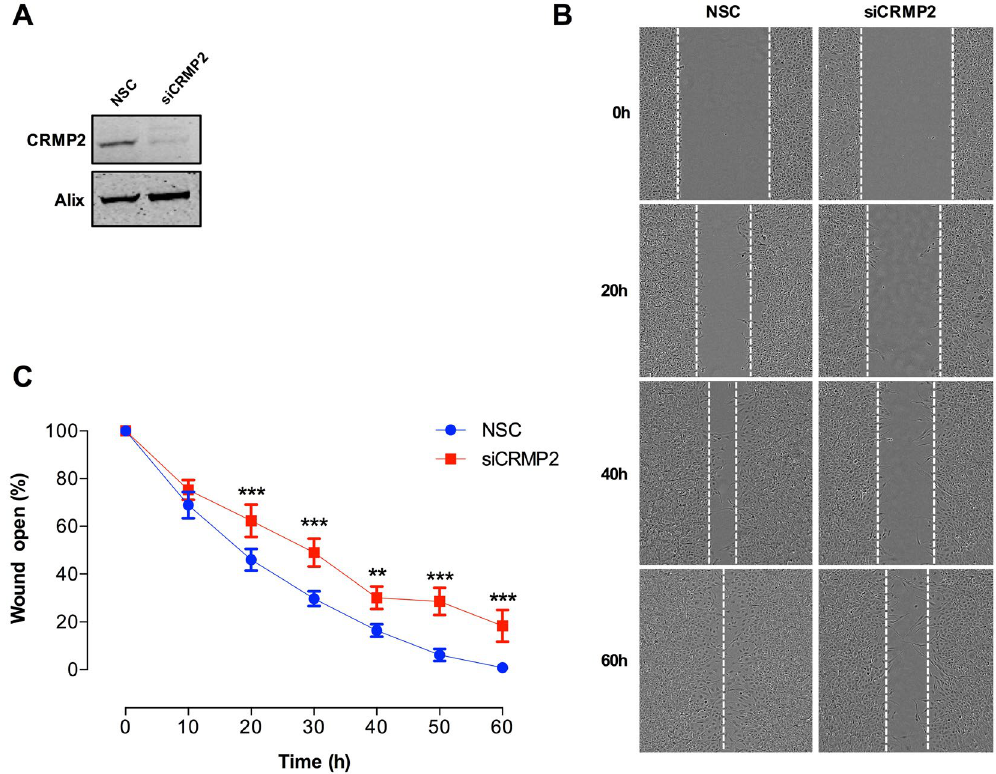
Figure 7. CRMP2 plays a role in PDGF-induced cell migration. ( A ) Representative western blot showing levels of CRMP2 in MEFs following transient transfection with non-silencing control siRNA (NSC), or with CRMP2 siRNA (siCRMP2). Alix was used as a loading control. For uncropped images of blots see Supplementary Fig. S4. ( B ) Transfected MEFs were wounded using an automated scratch maker and stimulated with 20 ng/ ml PDGF. Images of five separate wounds were taken at 0, 10, 20, 30, 40, 50, and 60 h post wounding using the IncuCyte ZOOM imaging system. ( C ) The percentage of the wound open at each time point was quantified using ImageJ. Data are presented as average % wound open and error bars represent the standard error of the mean (n = 3; ** P < 0.01, *** P <